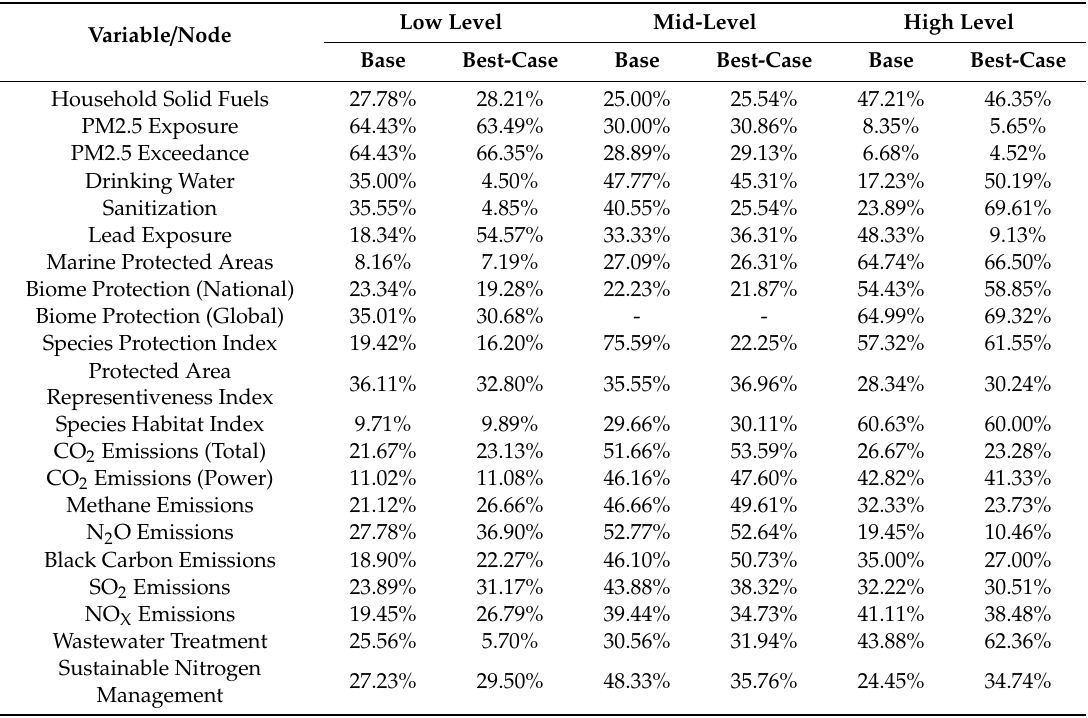
Table 3. Results of predictive analysis of the best-case